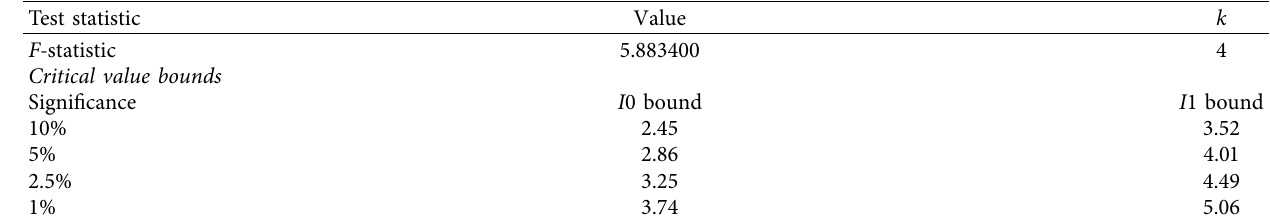
Table 2: ARDL bounds test to cointegration.